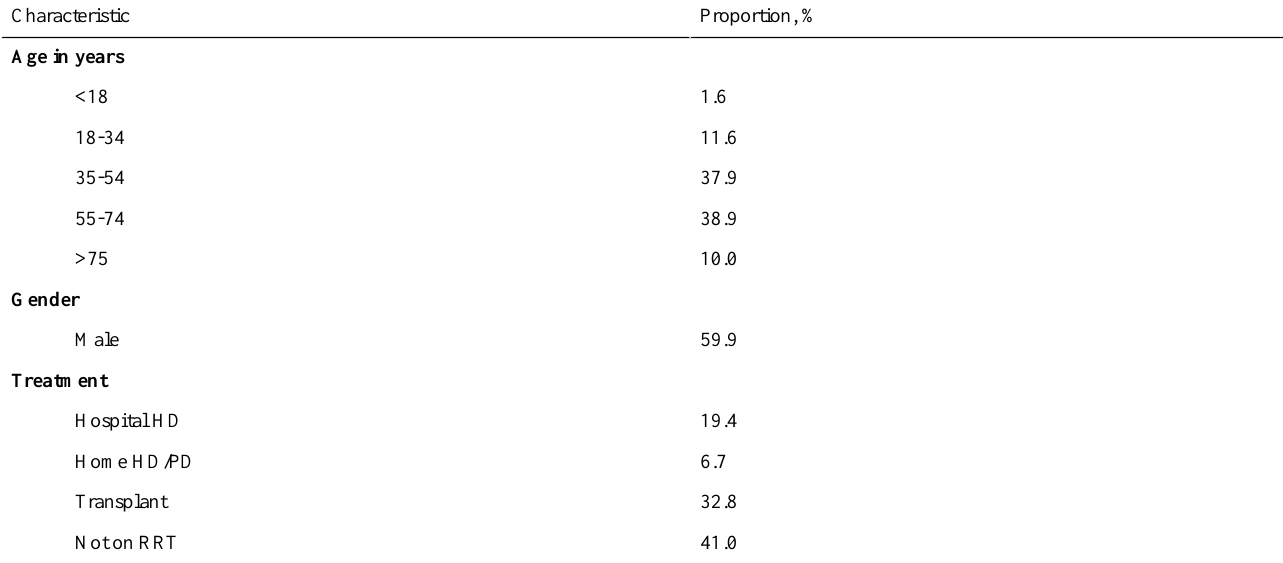
Table 2. Description of the entire RPV-registered population (N=11,352).